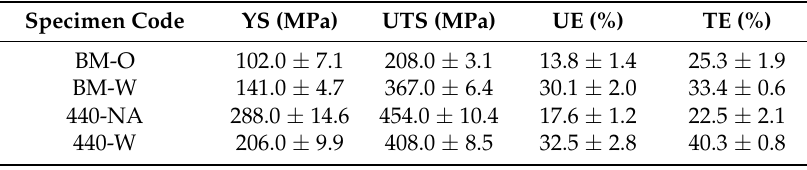
Table 2. The tensile properties of 7075-BM and FSPed specimens after various heat treatments. YS: yield strength; UTS: ultimate tensile strength; UE: uniform elongation; TE: total elongation.